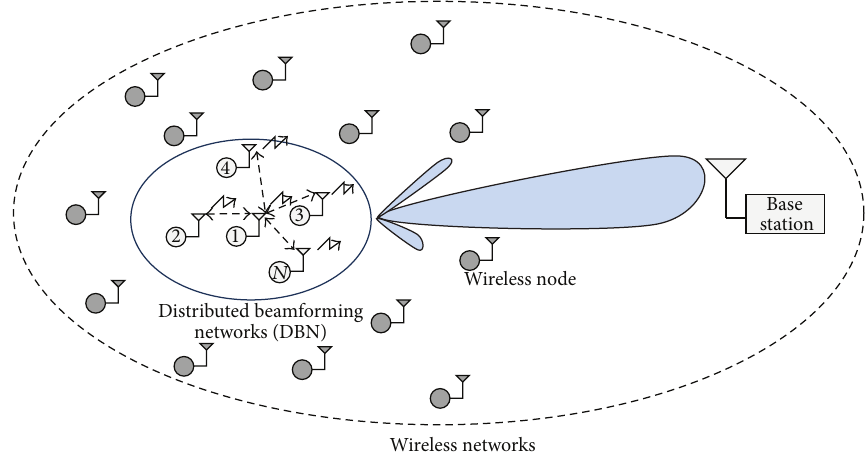
Figure 1: Configuration of wireless networks employing a distributed beamforming.